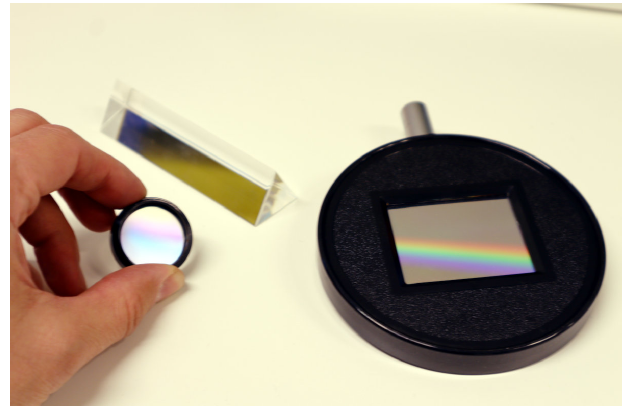
Fig. 15.— The three basic types of dispersive element, from left to right: transmission grating, prism, and reflective grating